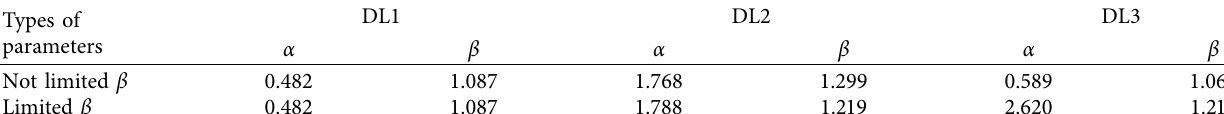
Table 6: Parameters of fragility curves for each damage level.